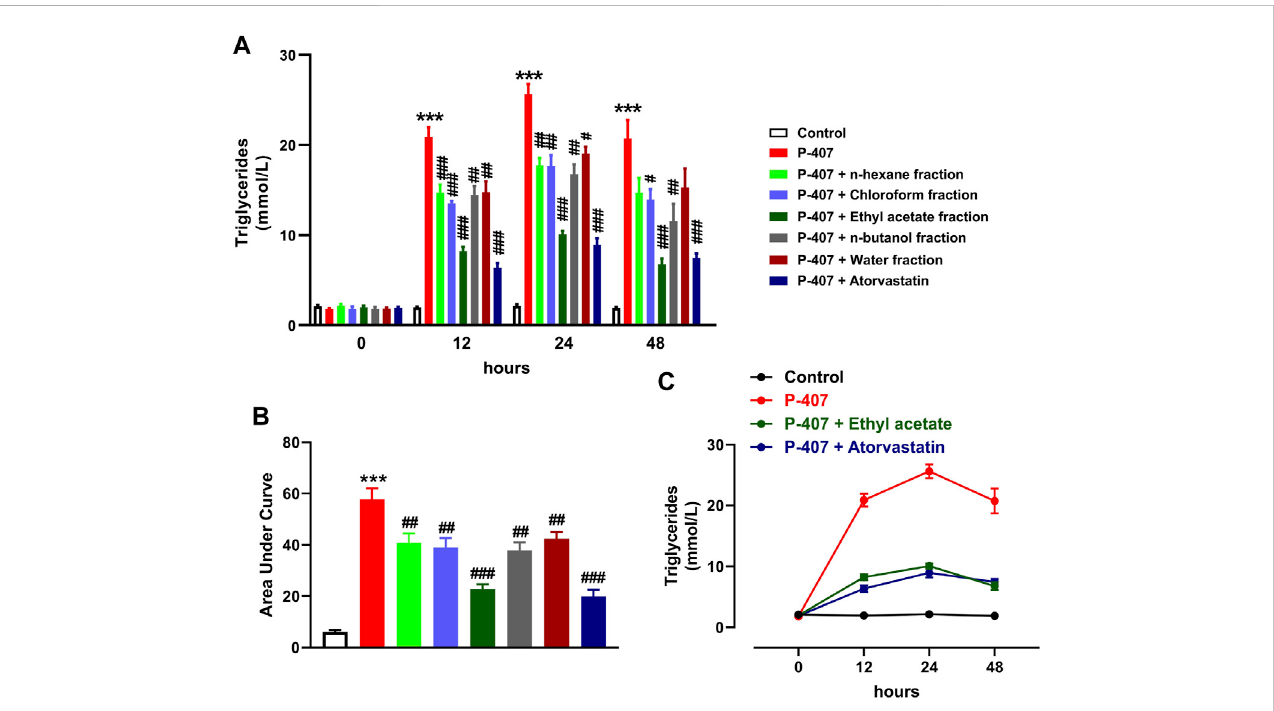
FIGURE 7 Effect of different fractions of MEACL on TG levels at 0, 12, 24, and 48 h (A, B) . Changes in TG levels in control, hyperlipidemic and hyperlipidemic rats treated with ethyl acetate fraction or atorvastatin (C) . Values are represented as mean ± SEM ( n = 6). *** p < 0.001 versus Control, and # p < 0.05, ## p < 0.01, and ### p < 0.001 versus